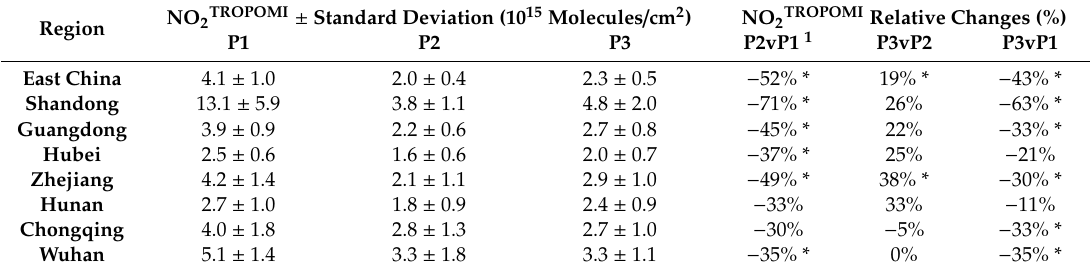
Table 1. Averages and standard deviations (temporal variability) of NO 2TROPOMI during three periods and the relative changes between the three periods.